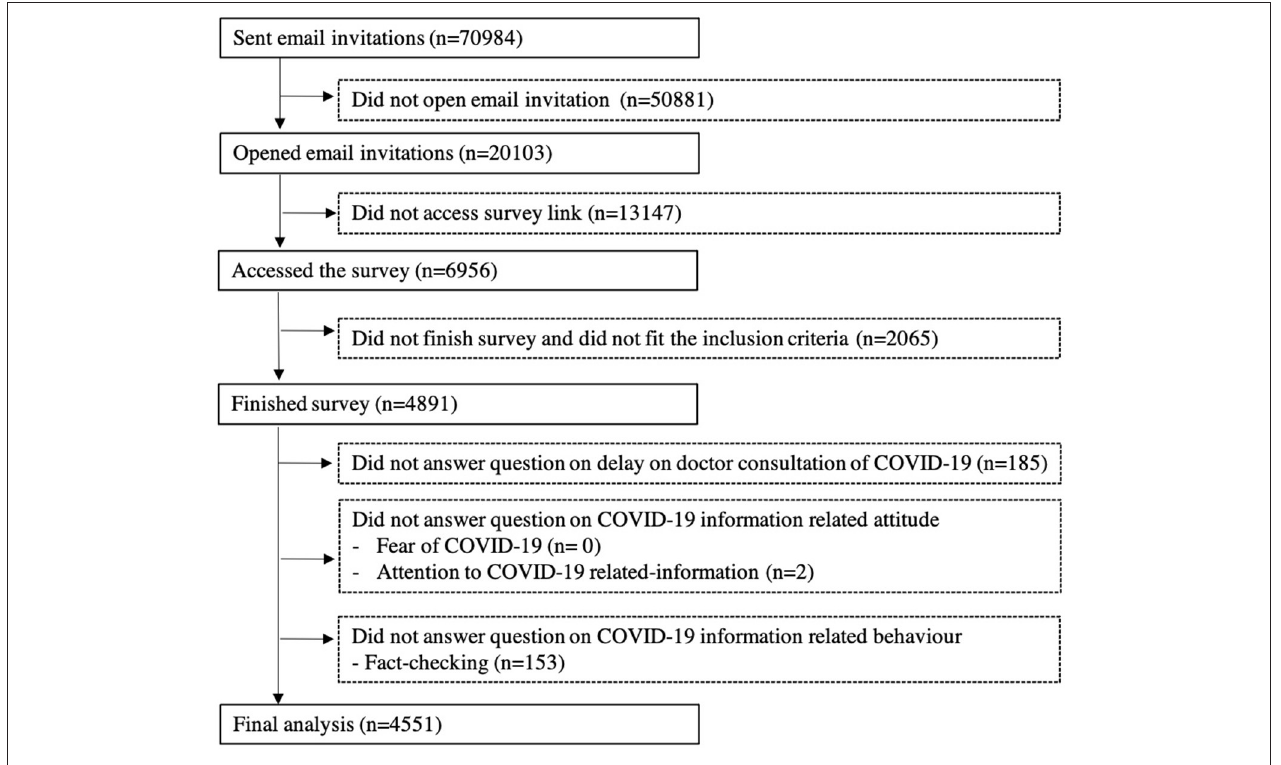
FIGURE 1 | The survey recruitment flow